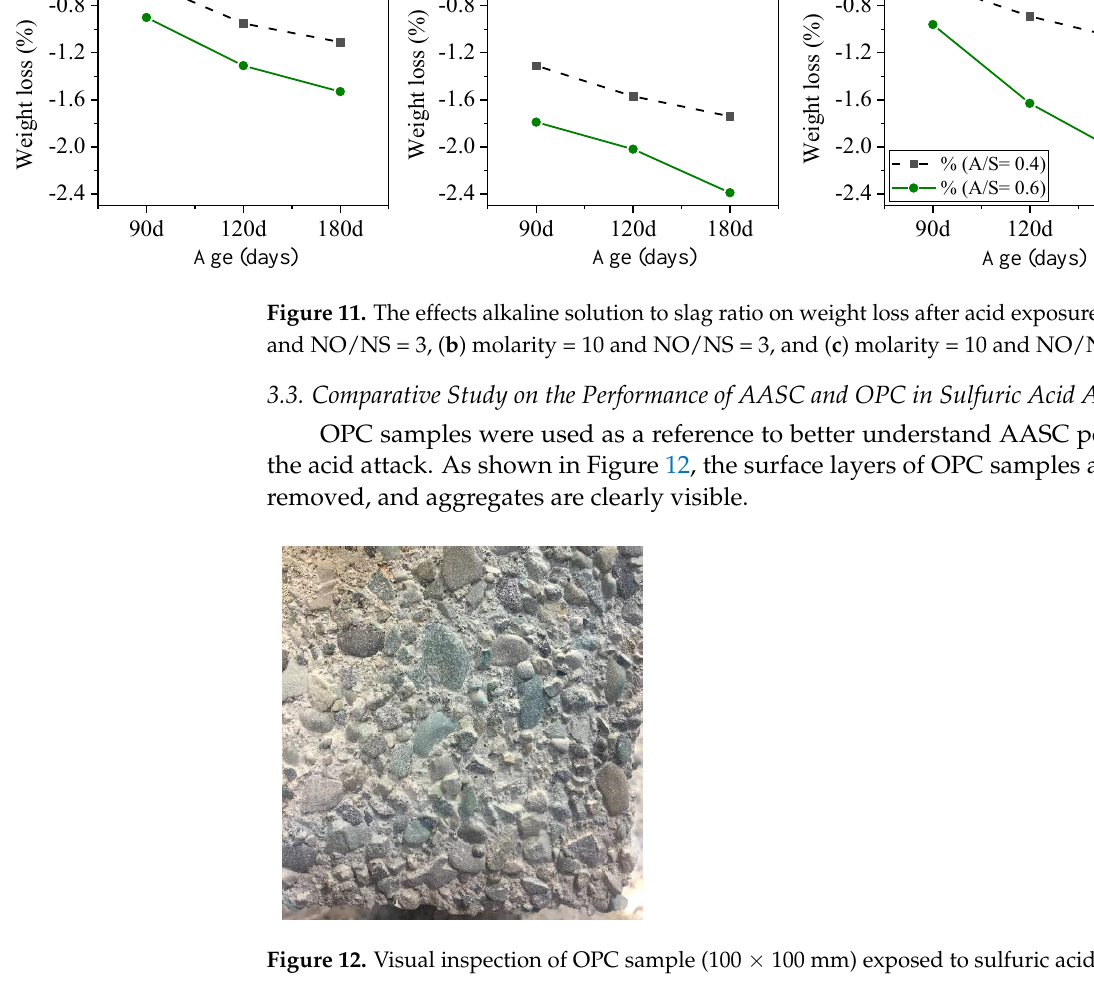
Figure 10. The effects of the alkaline solution to slag ratio on compressive strength ( a ) at a molarity of 6 and ( b ) at a molarity of 10 (A/S: the weight ratio of alkali solution content to slag).